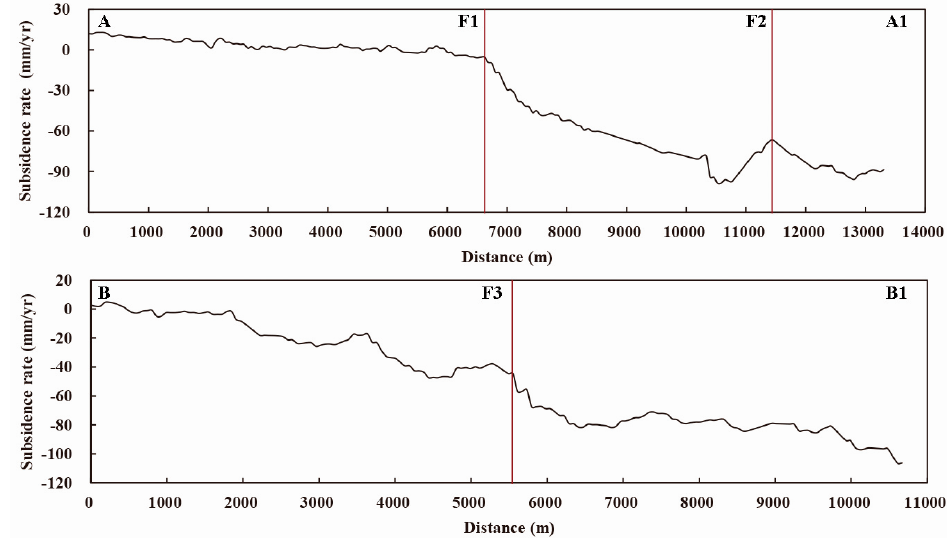
Figure 9. Land subsidence rate with profiles A–A1 and B–B1. The red line is the location of the faults.